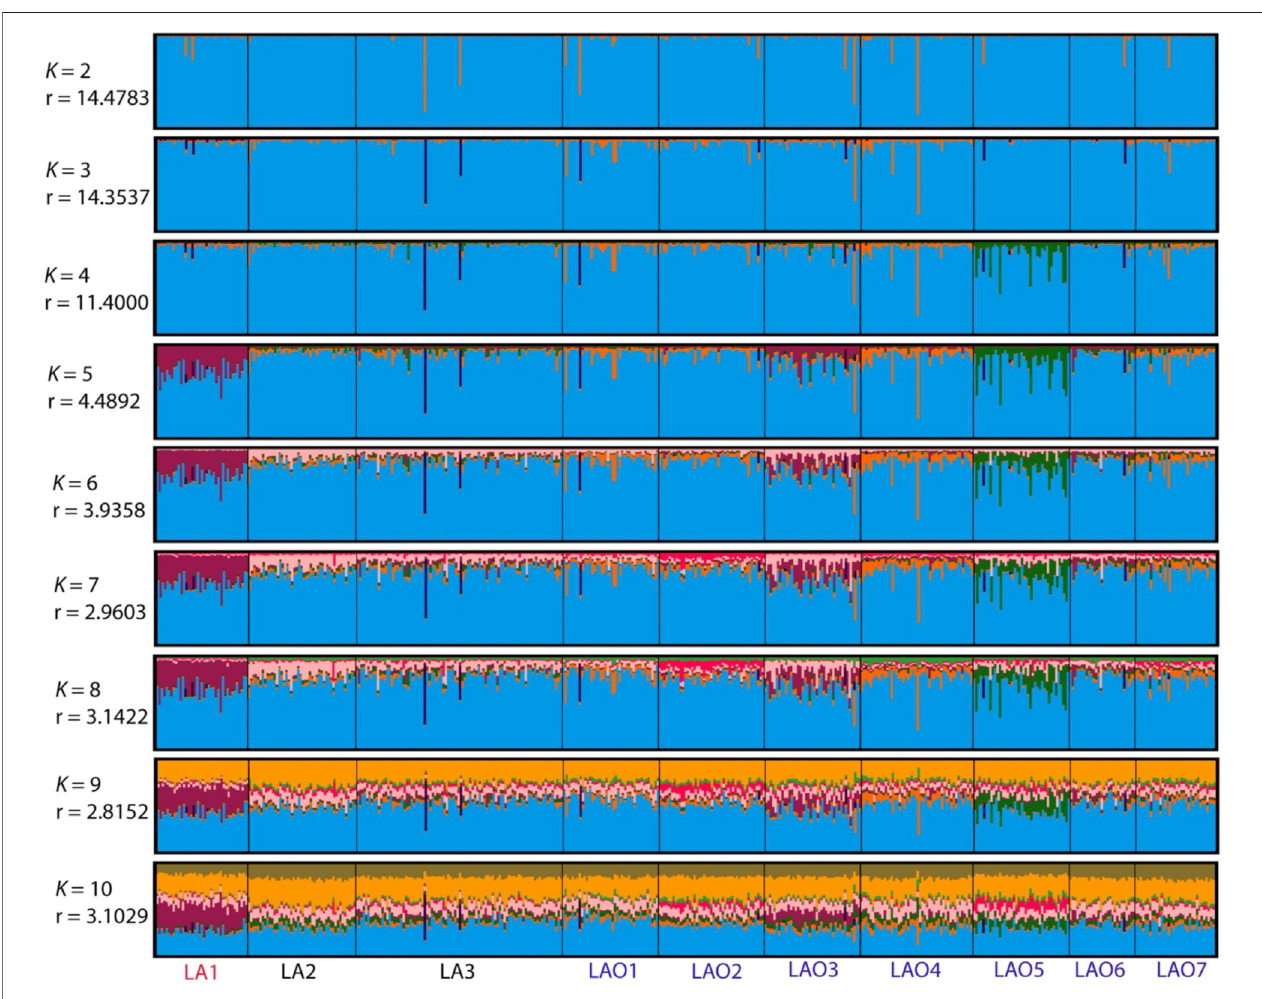
FIGURE4| TheSTRUCTUREresultof10populationsfromnumberofcluster( K )=2to10.Eachindividualpopulationisrepresentedbyasinglecolumndividedinto segments whose size and colour correspond to the relative proportion of a particular cluster. Populations are separated by black lines. Population names are color- coded; red, black and blue represent AA-speaking Laotian, TK-speaking Laotians and Lao Isan populations, respectively. The parameters “ r ” indicate the informativeness of sampling location data.